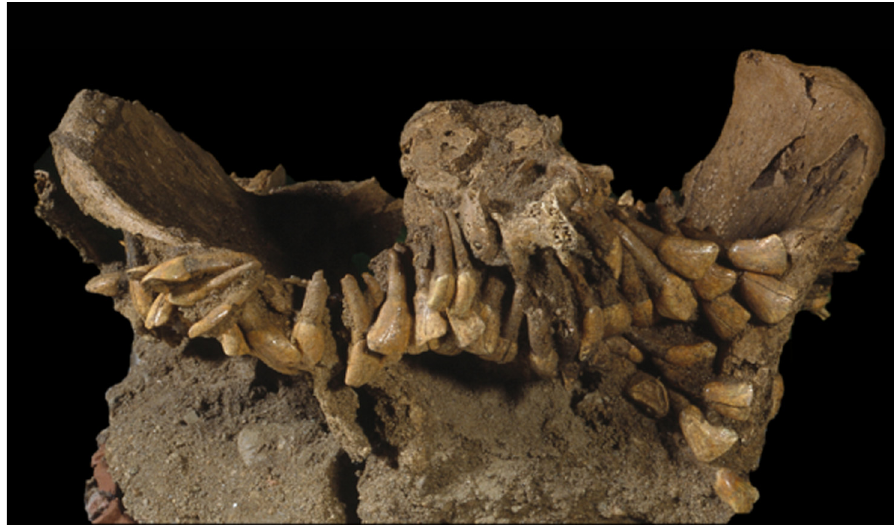
Figure 2: Tooth beads around the waist of a woman in Grave VIII, Skateholm II. Photo: Lars